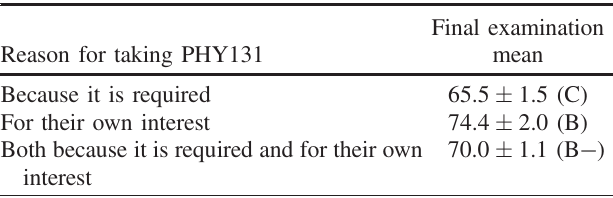
TABLE II. Final examination performance for different reasons for taking the